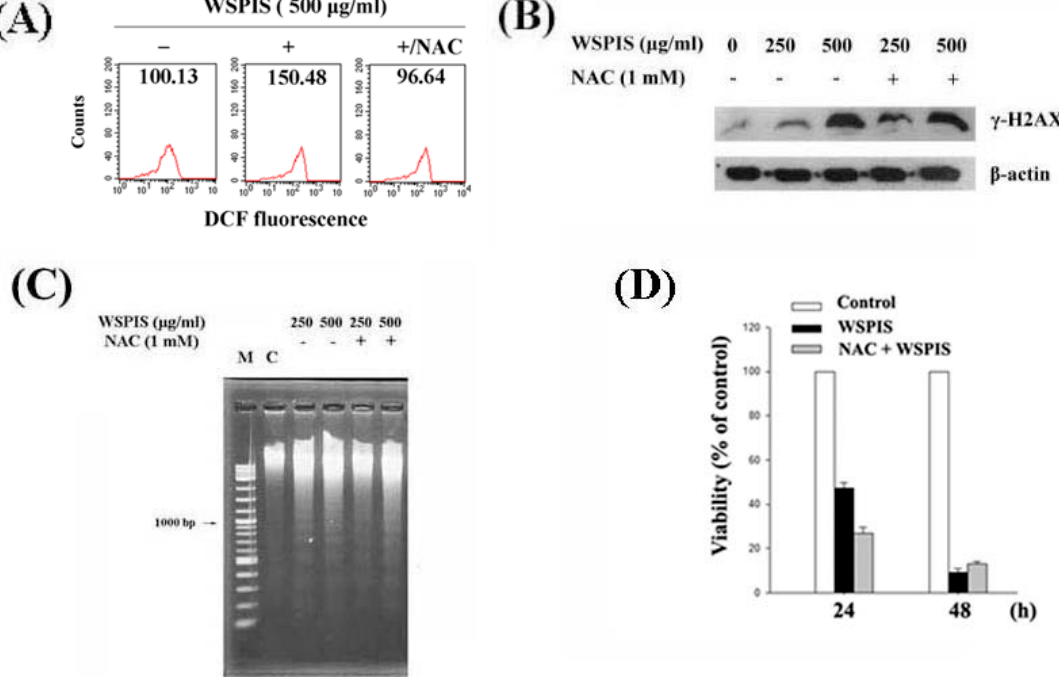
Figure 6. Effect of N -acetyl- L -cysteine (NAC) on WSPIS-induced DNA damage and apoptosis in THP-1 cells. Cells were pretreated with NAC (1 mM) for 1 h followed by WSPIS treatment for the indicated time periods. ( A ) Intracellular ROS content was evaluated at 1 h after 500 µ g/mL WSPIS treatment by measuring oxidized DCF fluorescence using flow cytometry. ( B ) The protein level of γ -H2AX was determined by Western blotting at 48 h after WSPIS treatment. ( C ) Oligonucleosomal DNA fragmentation was analyzed by agarose gel electrophoresis at 48 h after WSPIS treatment. ( D ) Cell viability was determined by the trypan blue exclusion assay at 24 and 48 h after WSPIS treatment. Values are expressed as a percentage compared to the control. Data are representative of three independent experiments.